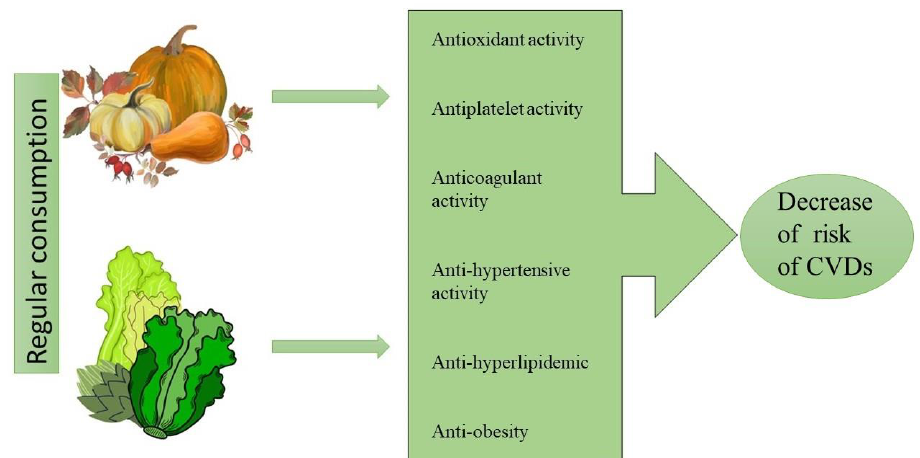
Figure 1. The effect of selected vegetables from Cucurbitaceae and Asteraceae family on development of cardiovascular diseases.